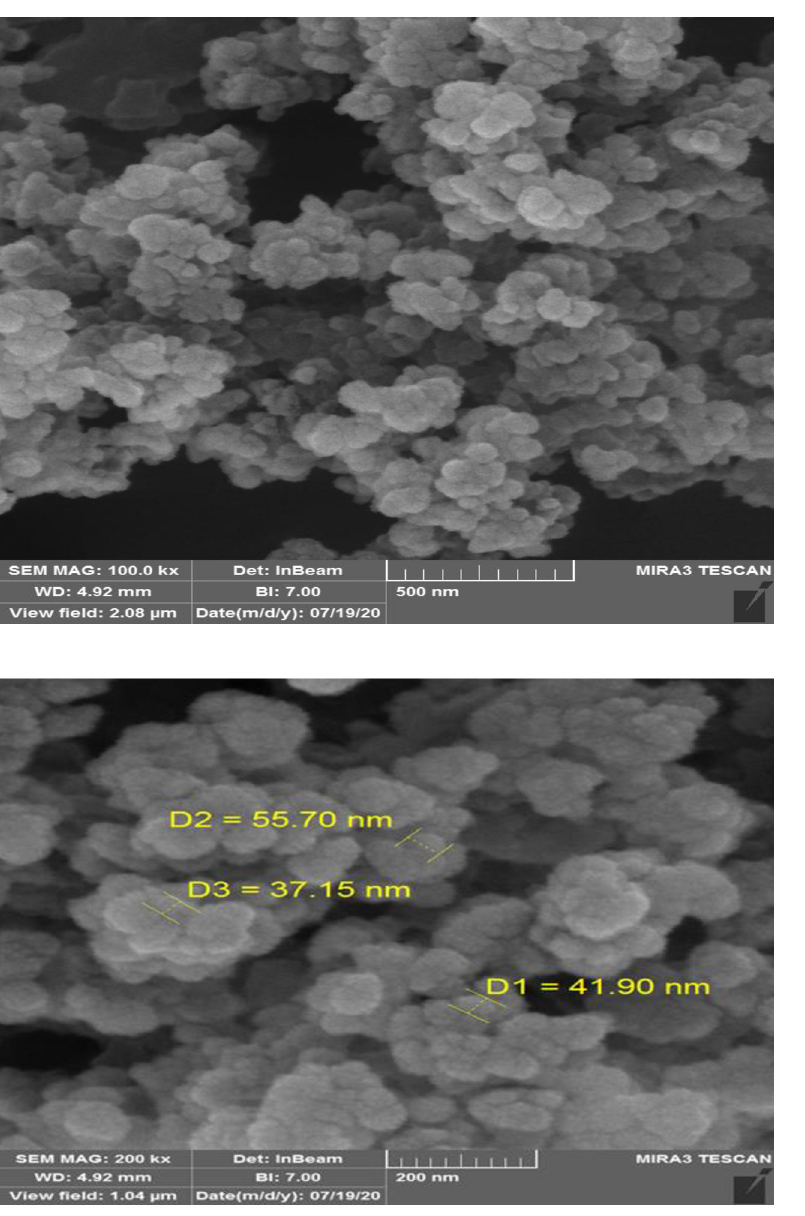
Fig 2. SEM image of molecularly imprinted polymers of the CBZ. from the linear graph of I VS v 1/2 was found to be 7.2 × 10 − 6 cm 2 S -1 . P Where I is peak current ( µ A), n is the number of electrons, A is sensing area cm 2 , D P sion coefficient ( cm 2 / s ), ν is scan rate mv/s C is concentration ( mol/cm 3 ). 0 It was concluded that MWCNTs-MIPs had the booting effect on the specific surface area and electron transfer compared to the bare electrode.